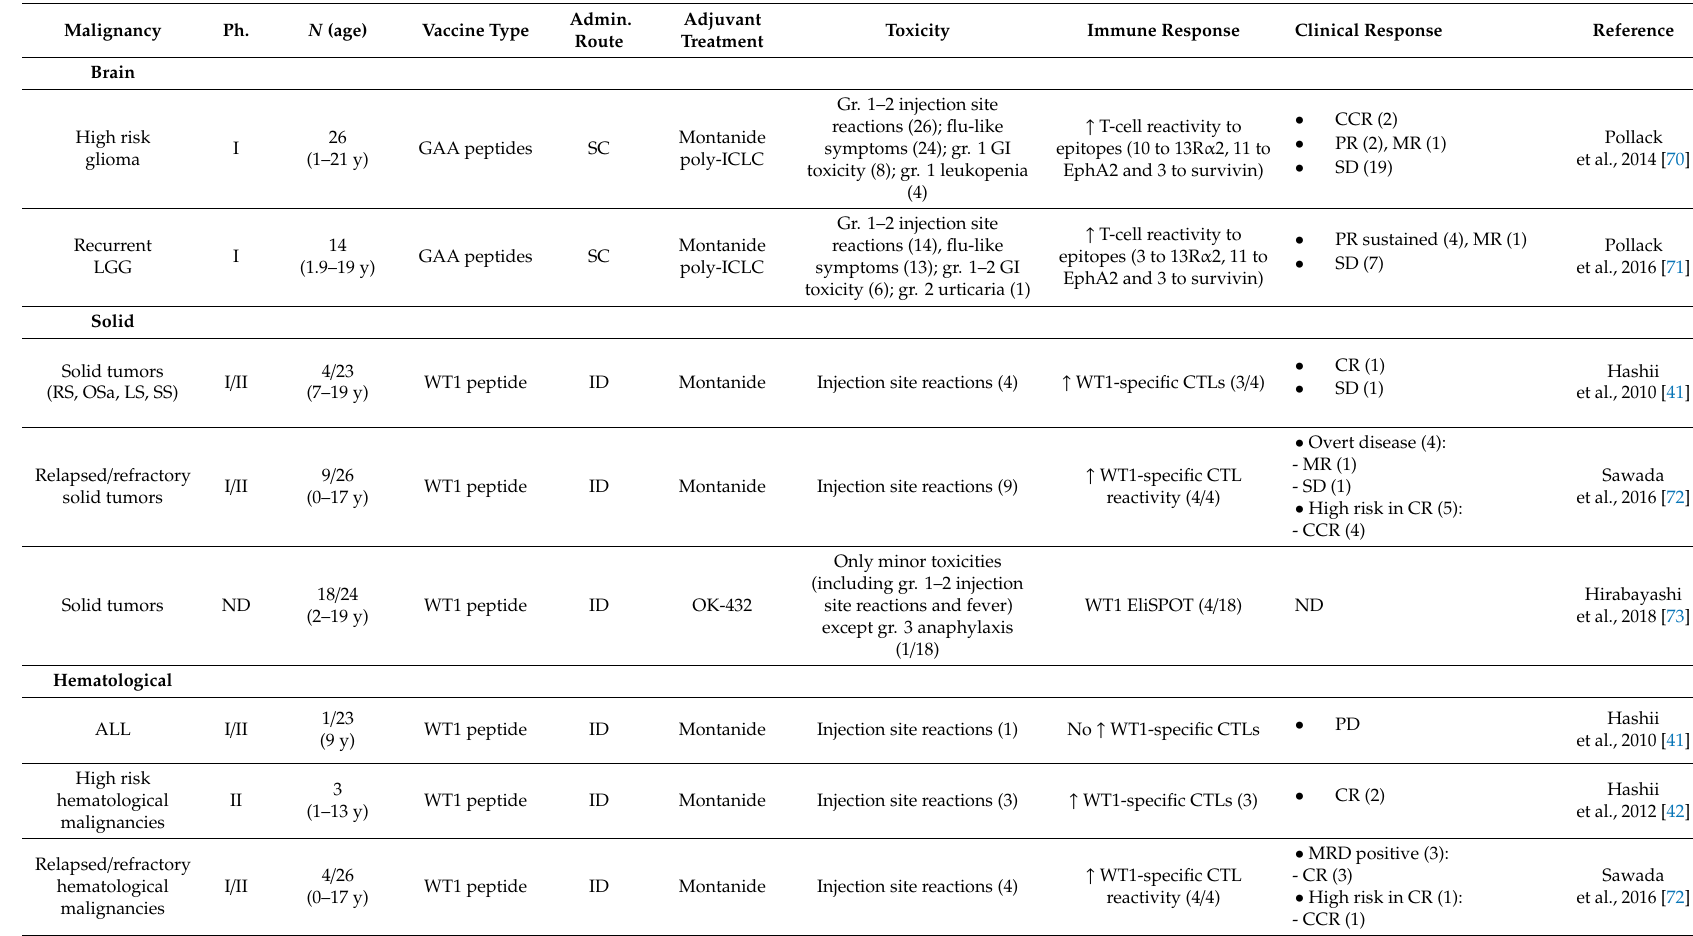
Table 3. Published peptide vaccination studies involving pediatric cancer